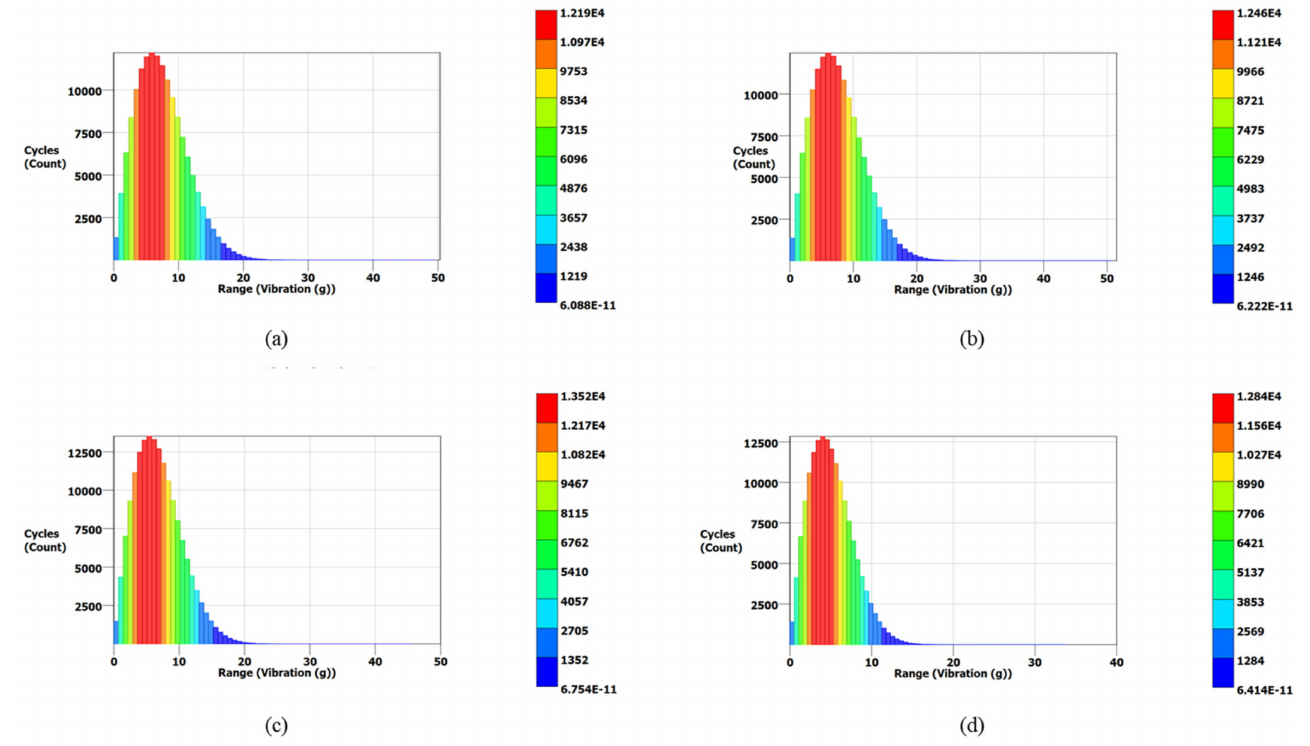
Figure 17. PDF results for turbine blades using the narrow-band approach: ( a ) the solid blade; ( b ) the 0.75 mm lattice blade; ( c ) the 0.50 mm lattice blade; ( d ) the 0.25 mm lattice